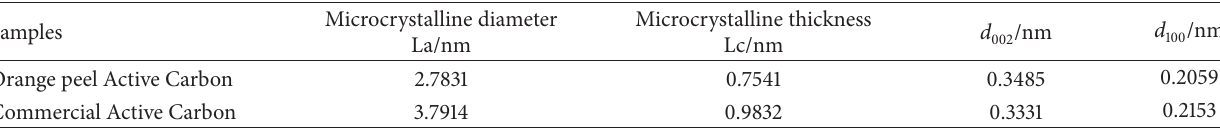
Table 1: Crystalline parameters of activated